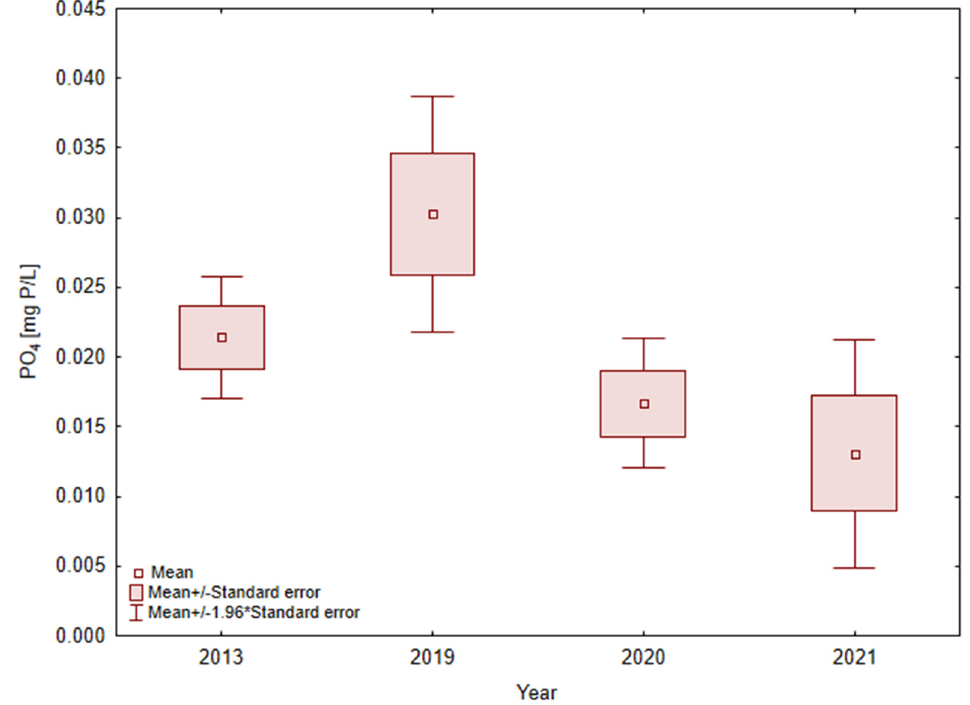
Figure 3. Average annual values of PO 4 content in the water of Lake Mielenko.